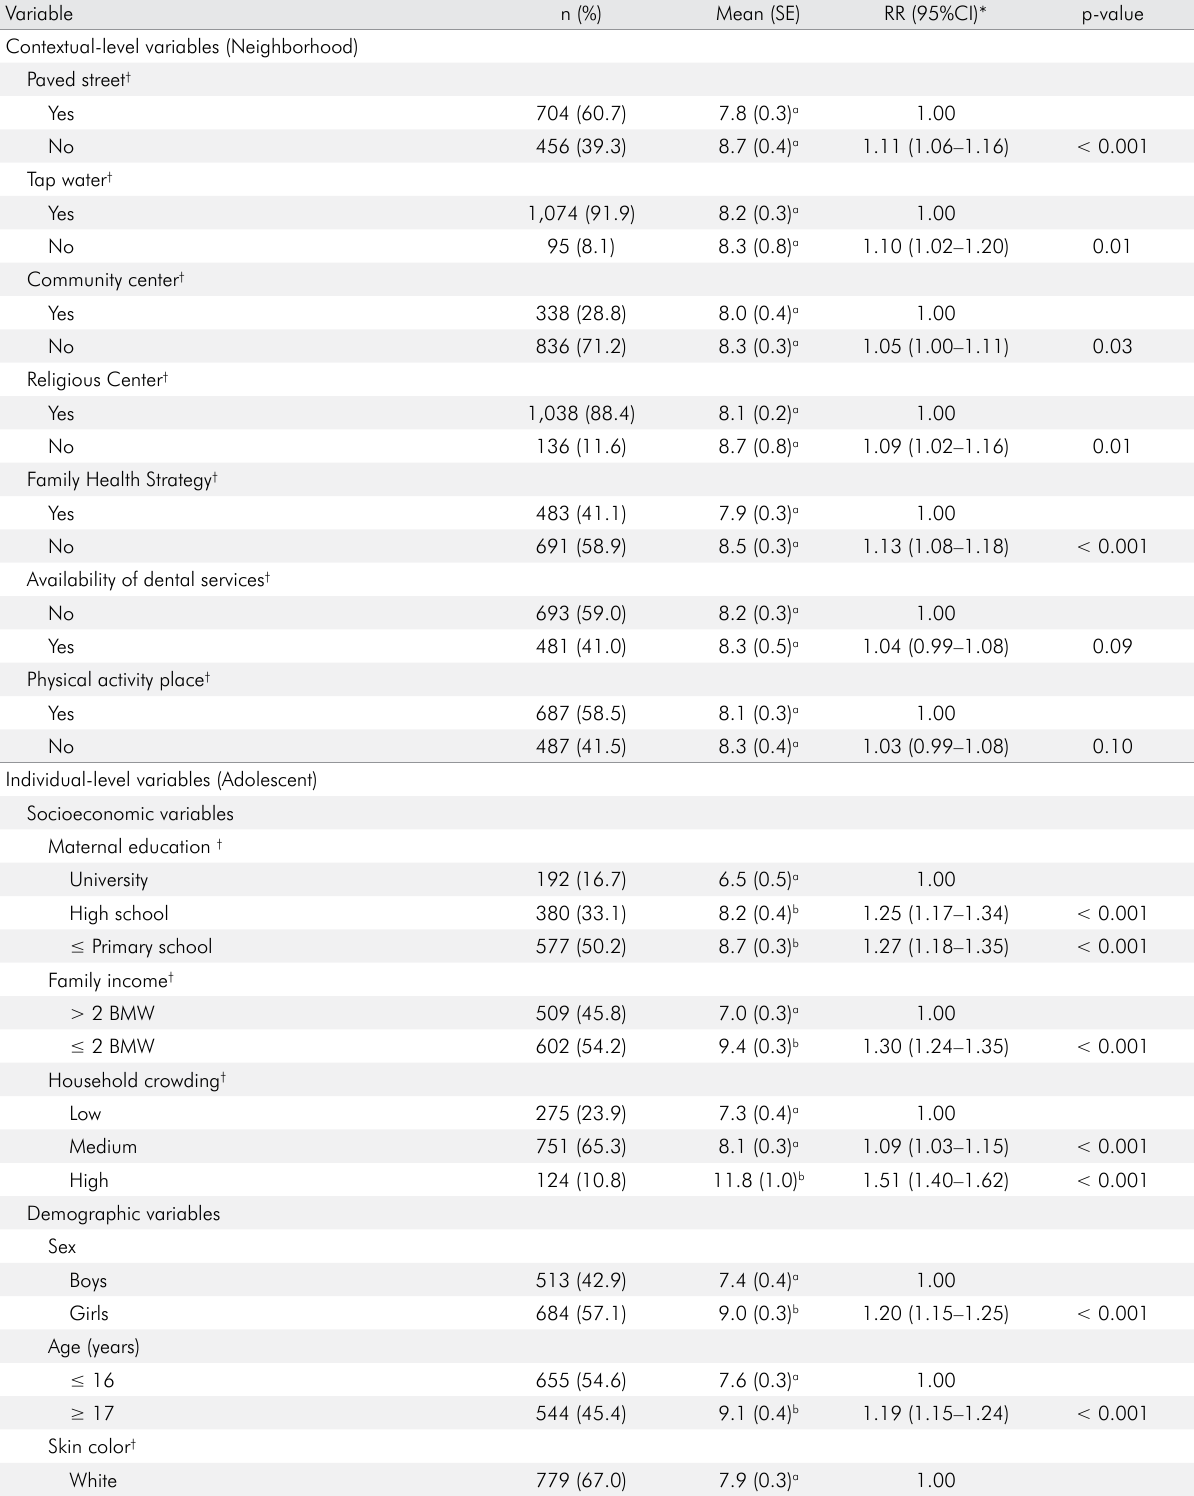
Table 1. Characteristics of sample, mean OHIP-14 scores, and the unadjusted association between explanatory variables and OHIP-14 scores (n =